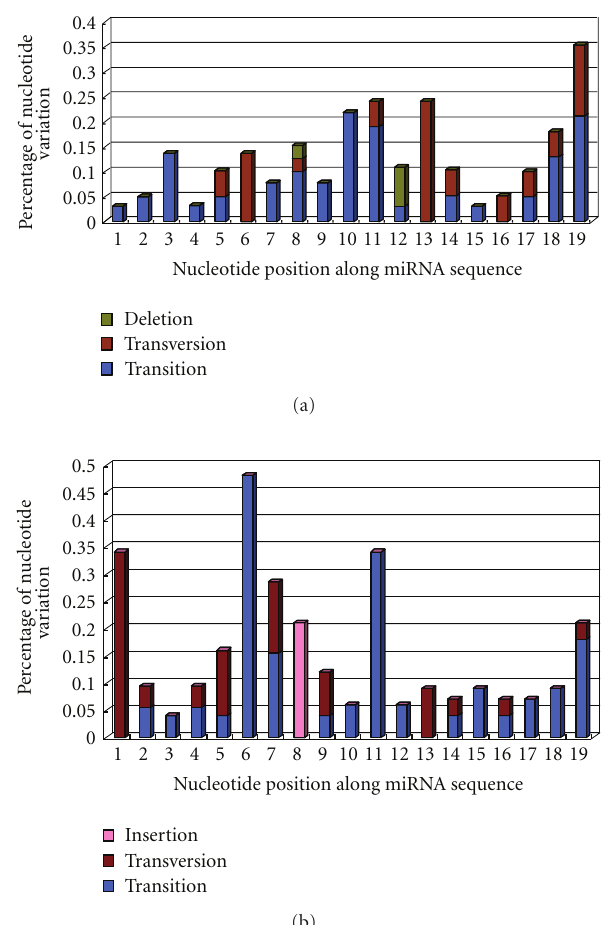
Figure 3: Mutational profiles of hsa-miR-548-5p (a) and hsa-miR- 548-3p (b) populations. Products of hsa-mir-548 gene family are estimated their mutational profiles according to each nucleotide position along miRNA sequence. Although these miRNA sequences have higher sequence similarity, higher level of nucleotide variation can be detected between miR-548-5p and miR-548-3p populations, especially the